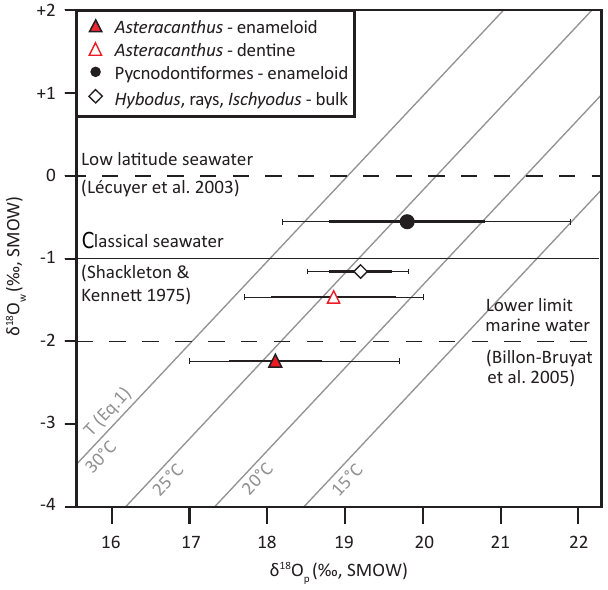
Figure 4. Graphic representation of the δ 18 O p values (average, standard deviation, end members) measured for Porrentruy in this study and their corresponding water temperature using Eq. (1). Comparable water temperatures for all taxa require different δ 18 O w values, which relate to salinity. Bulk and dentine values might have suffered diagenesis. Note the strong difference between δ 18 O w of Pycnodontiformes and Asteracanthus enameloid values (i.e. distinct palaeoenvironments) when similar ecological T is assumed. The wide value range of Pycnodontiformes indicates a tolerance to salin- ity fluctuations occurring within the platform, and possibly a living area broader than the shallow-marine platform. No attempt to define the final δ 18 O w values or water temperatures is made